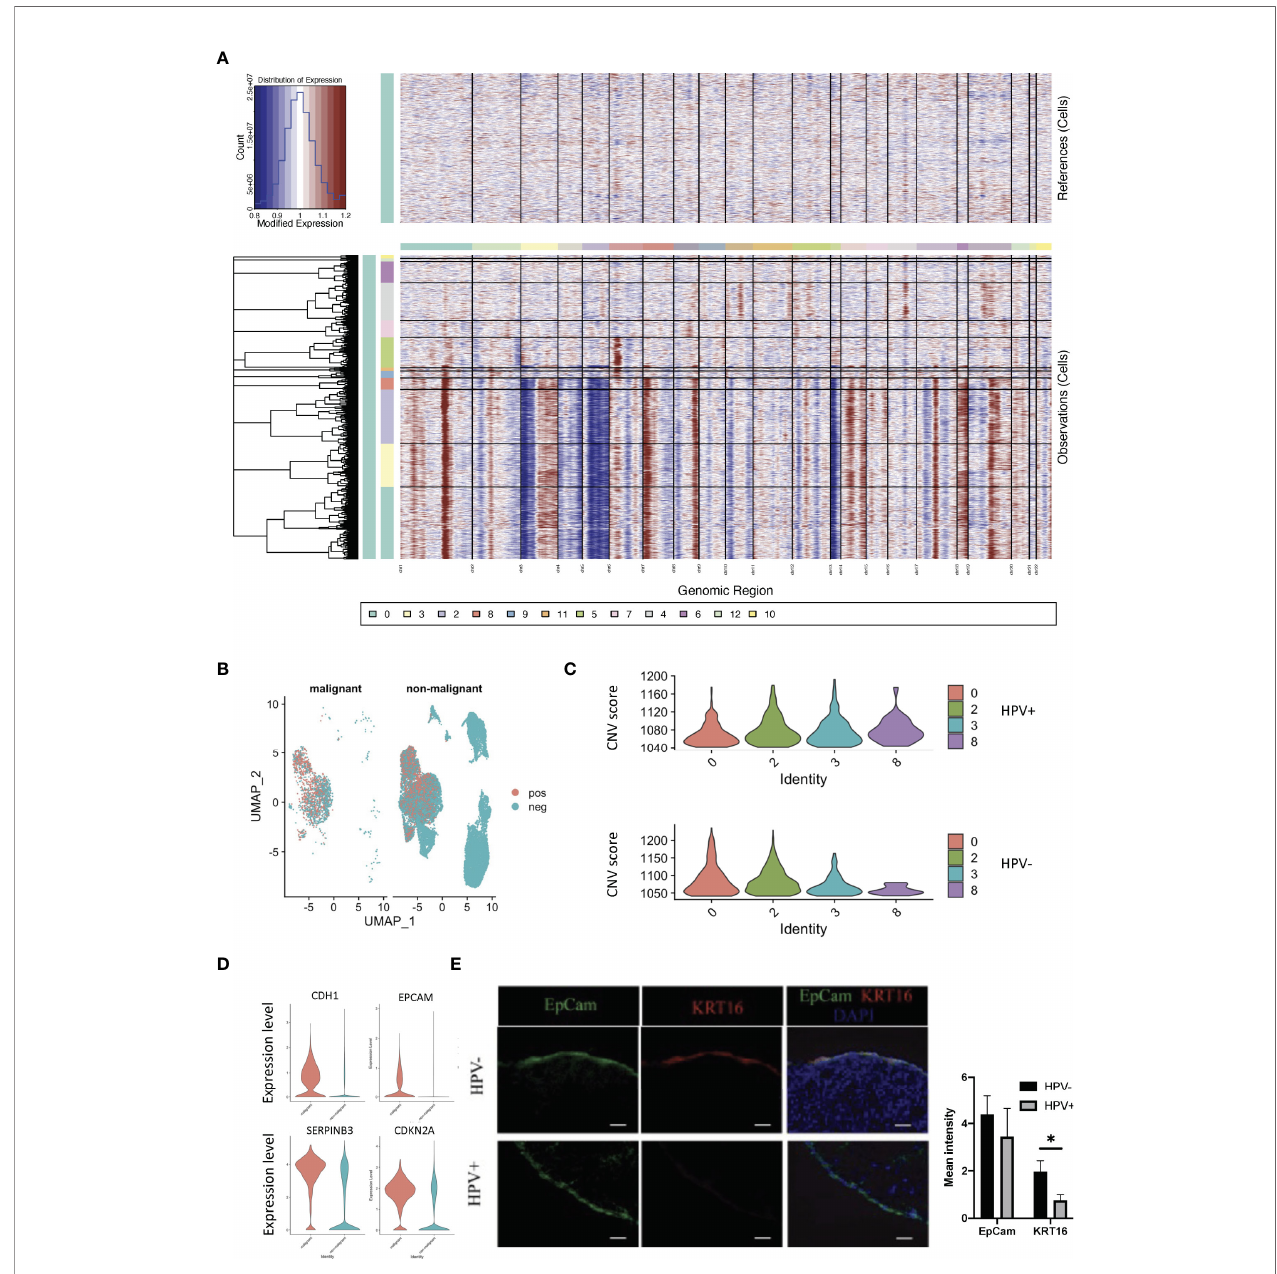
FIGURE 3 | CNV analyses of HPV + tumor cells. (A) CNV plots showing the malignant cells in the normal and tumor tissues. (B) UMAP diagrams showing non- malignant and malignant cells in the normal and tumor tissues. (C) CNV scores in the tumor cell clusters. (D) Violin plots indicating the levels of malignant-related gene expression in the non- malignant and malignant cells. (E) Representative immunostained photomicrographs of KRT16 in the tissues from HPV - and HPV + patients. EpCam staining refers to the squamous cell carcinoma. Scale bar indicates 50 m m. The bar graphs show the mean fl uorescent intensity of the indicated staining. * indicates p<0.05 of six